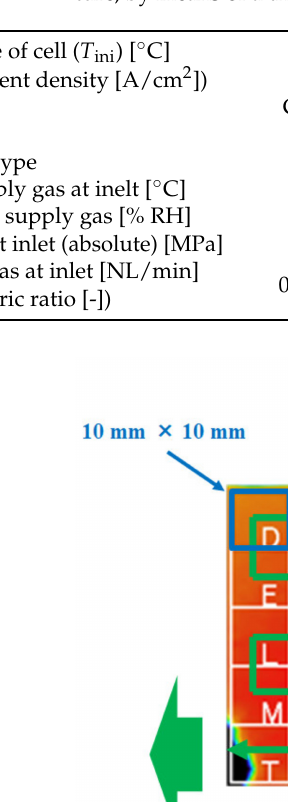
Table 2. Power-generation-operation conditions of polymer electrolyte fuel cell to measure tempera- ture, by means of a thermograph.